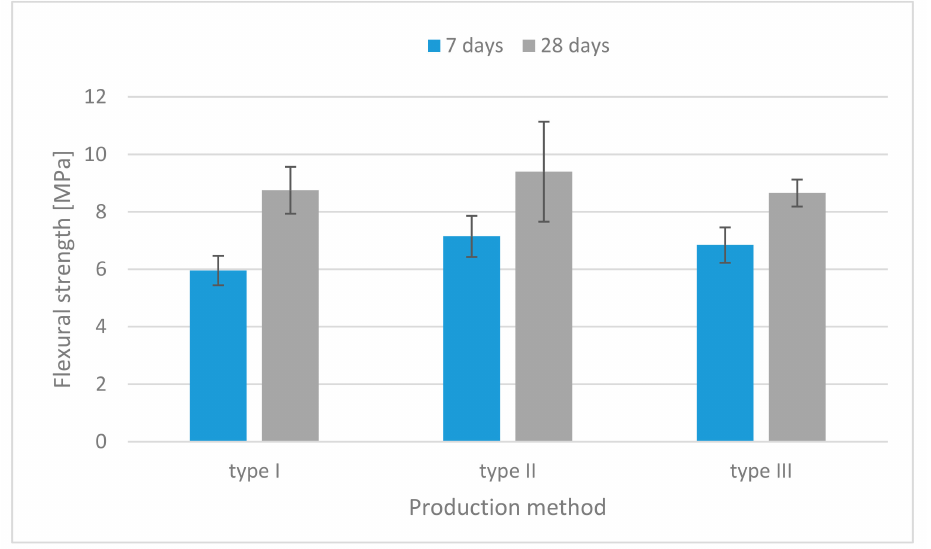
Figure 7. Flexural strength histograms (specimens containing flax